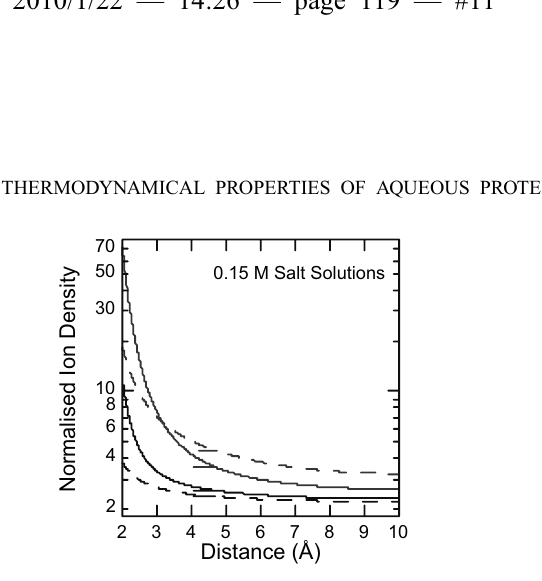
Fig. 5 – The ion density (anion+cation) normalized with the bulk values in between two charge regulated plates (that carry the same charge density and charge groups as hen-egg-white lysozyme, which is supposed to be uniformly smeared out on the surface) 20Å apart. The upper (lower) two curves are for pH 4 (pH 12) and the solid (dashed) lines correspond to 0.15 M NaSCN (0.15 M NaCl) (Boström et al. 2005c).